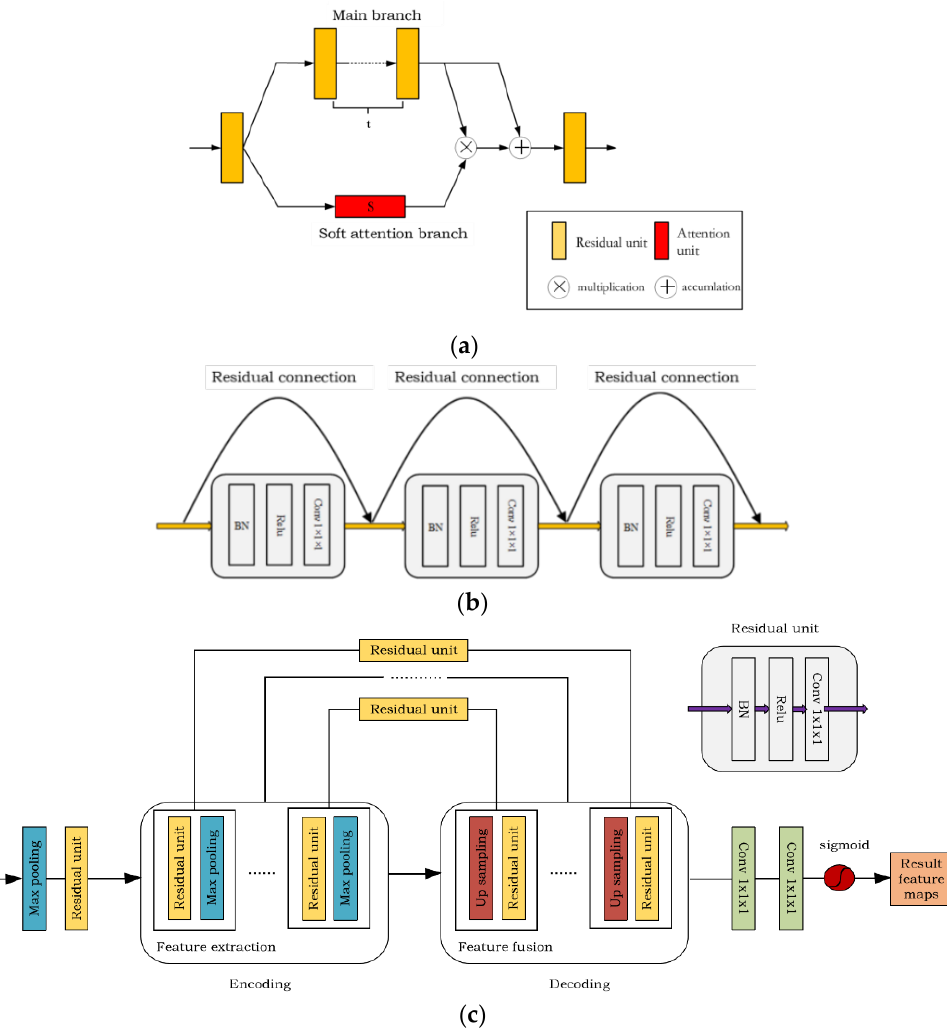
Figure 6. Attention module structure and its main branch and the soft attention branch structure diagram: ( a ) the attention module structure diagram, where t represents the number of residual units in the main branch; ( b ) the main branch structure diagram; ( c ) the soft attention branch structure diagram.